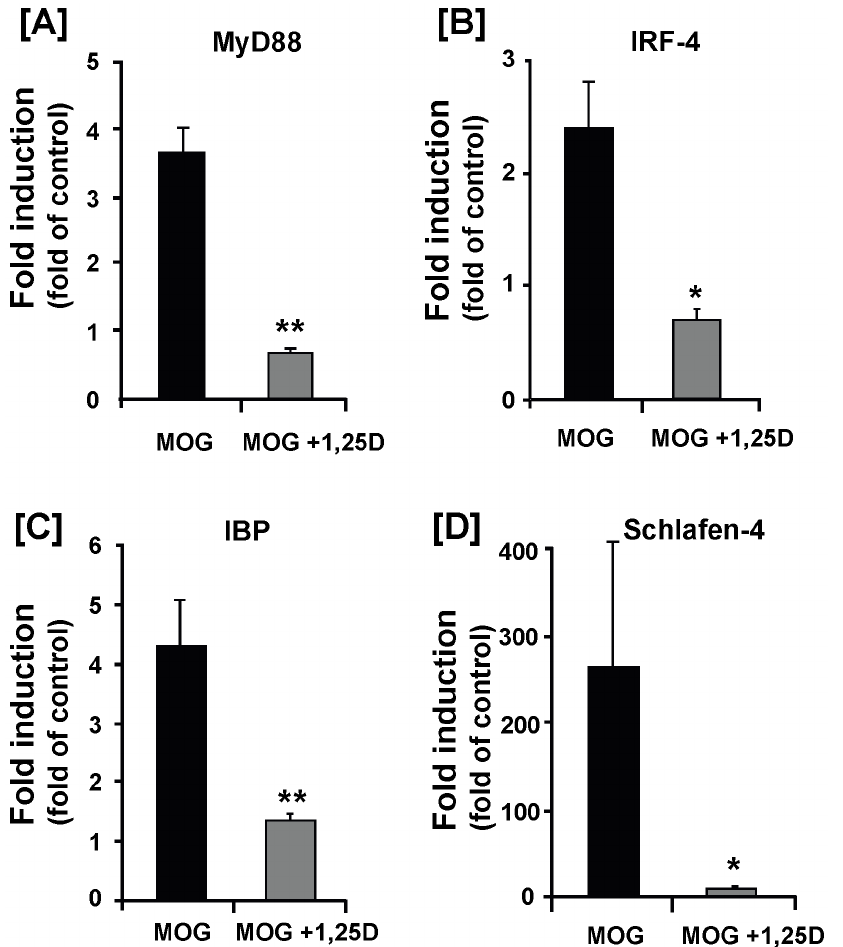
Figure 4. 1,25(OH) 2 D 3 inhibits activation of TLR8 signaling cascade in EAE. Animal treatments and spinal cord sample collections were described in Figure 1 legend. ( A–D ) Real-time RT-PCR analysis of the relative levels of mRNA for MyD88 ( A ), IRF-4 ( B ), IBP ( C ), and Schalfen-4 ( D